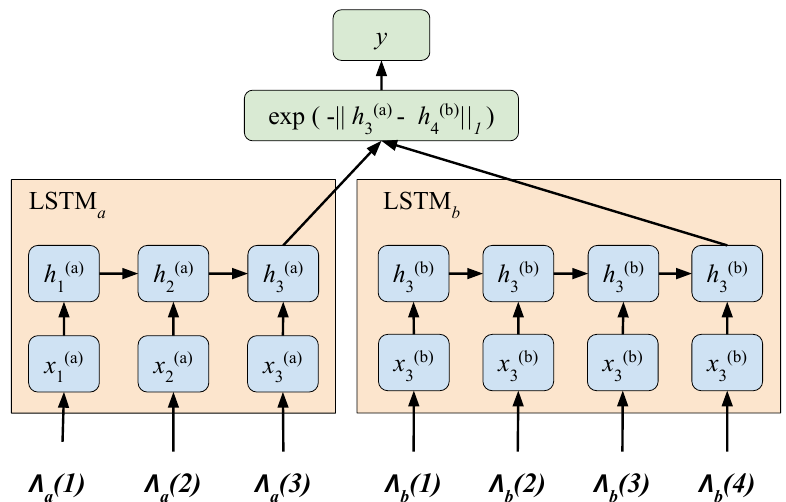
Figure 10. Siamese recurrent architectures for learning sentence similarity. Adapted from [47].